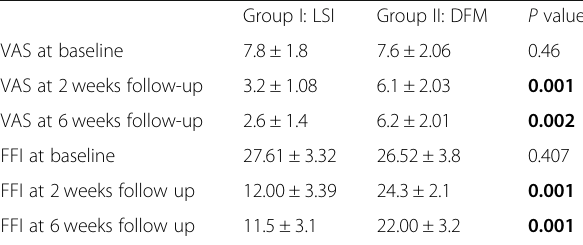
Table 2 Outcome measures at 2 and 6 weeks follow-up Group I: